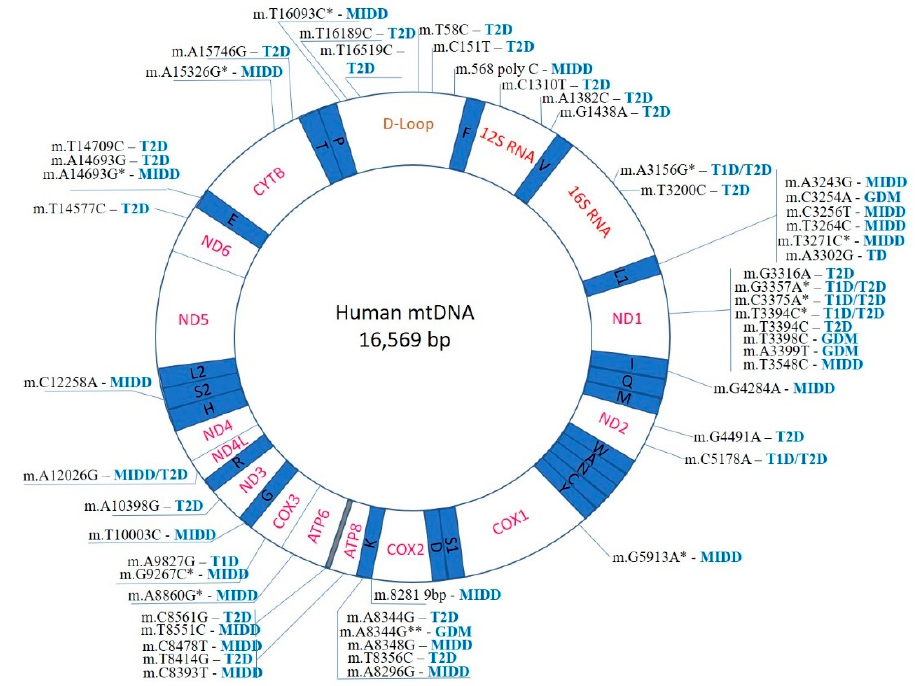
Figure 1. Mapping of known mtDNA mutations implicated in diabetes development. *- mutation identified in addition to m.3243G.